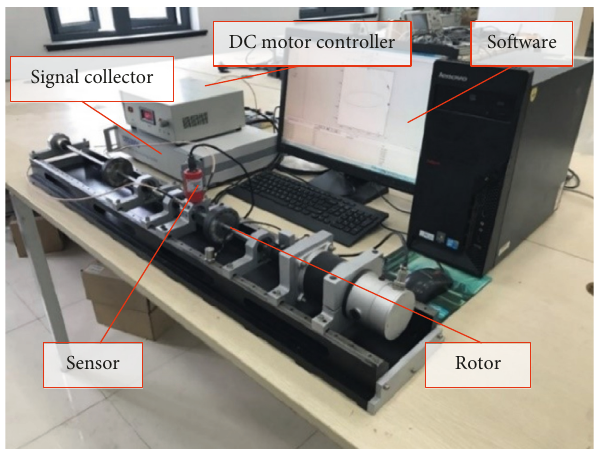
Figure 8: Structure of bearing rotor test bench.